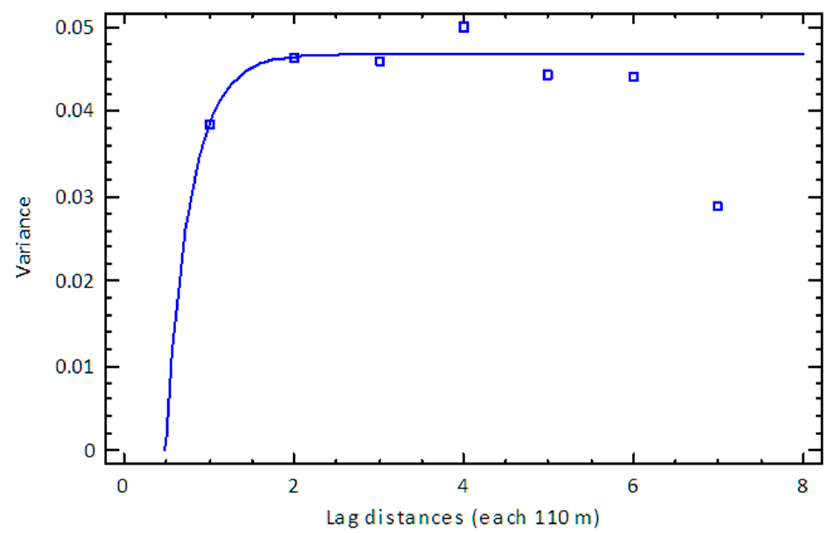
Figure 9. Tennant Creek exponential semivariogram model.